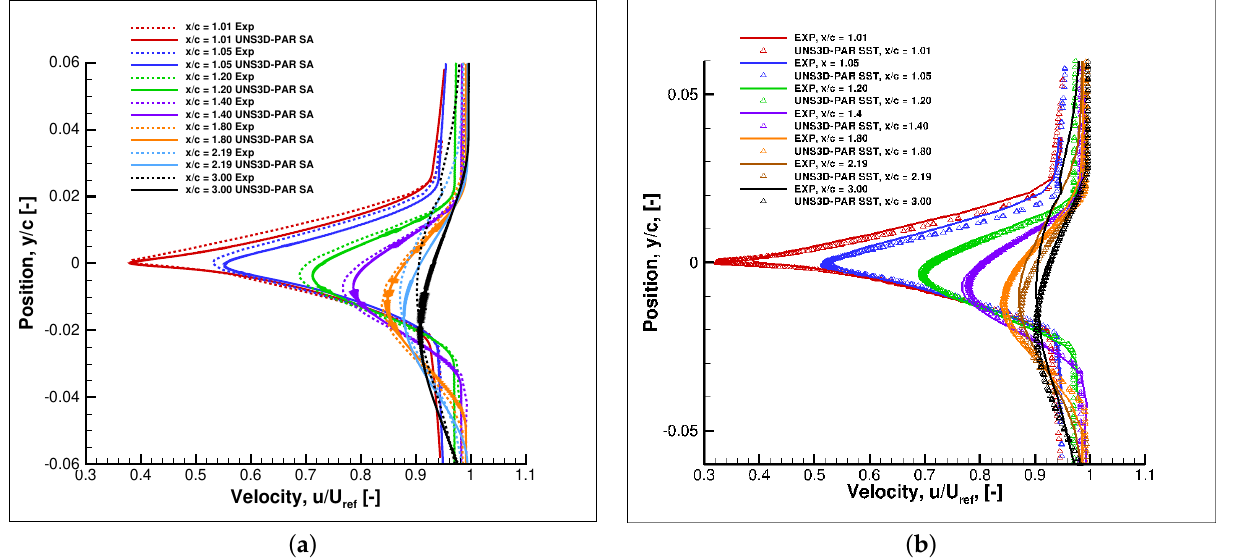
Figure 15. Velocity profiles on Nakayama’s airfoil: ( a ) Spalart–Allmaras, and ( b ) Shear Stress Transport. Figure 16 compares the measured turbulent shear stresses − u (cid:48) v (cid:48) against the predicted ones at the same seven locations in the wake. Both the Spalart–Allmaras and Shear Stress Transport models were used in the UNS3D-PAR code. The two turbulence models predicted the general shape of the shear stresses, although there were some differences between the predicted results and the experimental